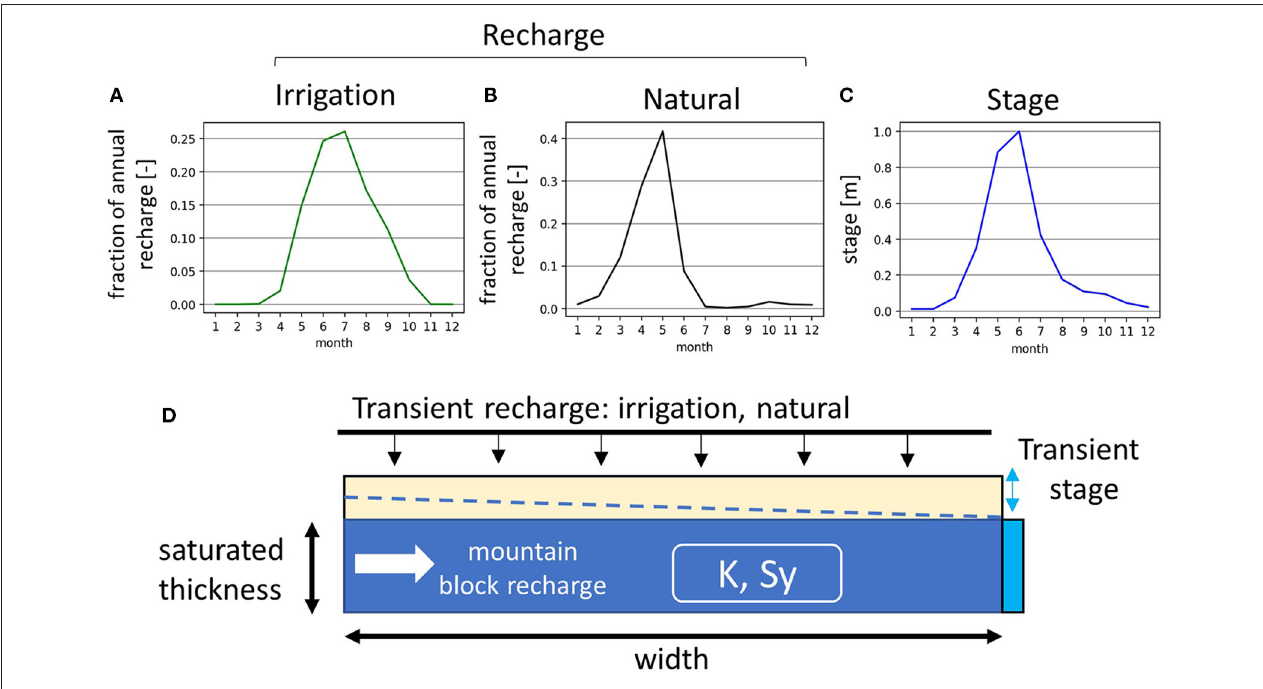
FIGURE 2 | Groundwater model design (D) . Transient recharge (flux) boundary conditions are applied to the model top representing irrigation recharge (A) and natural recharge is also included in a subset of simulations (B) , and transient stream stage based on normalized snowmelt-dominated stage hydrographs is imposed at the right boundary (C) . For model scenarios that include natural recharge, mountain block recharge is represented as constant-flux along the right boundary.